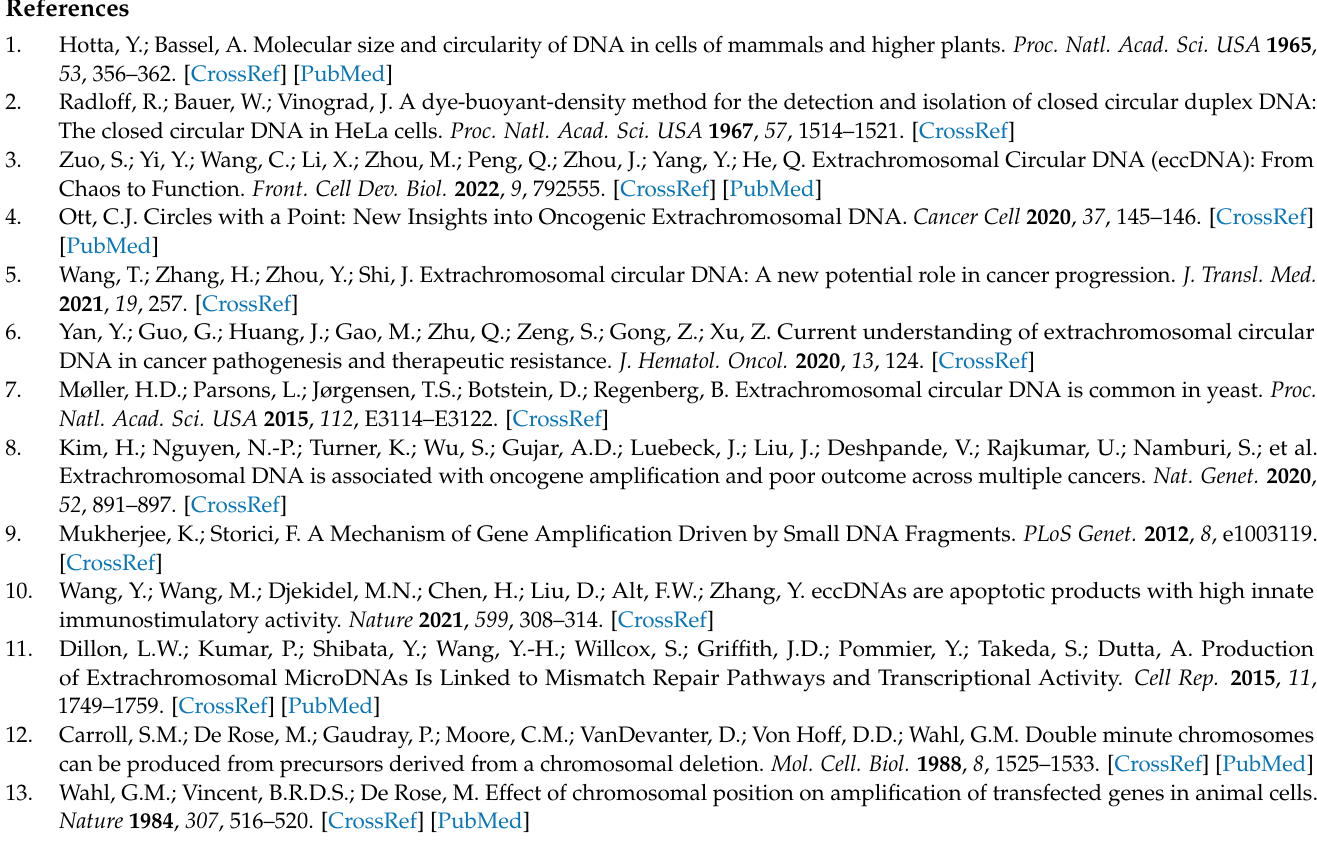
on the ends of circles with genes. This file shows all motifs found enriched in more than 50% of tumors. Table S5: Motifs enriched at ends of circles without genes. DNA motif enrichment analysis was performed for individual tumors on the ends of circles without genes. This file shows all motifs found enriched in more than 50% of